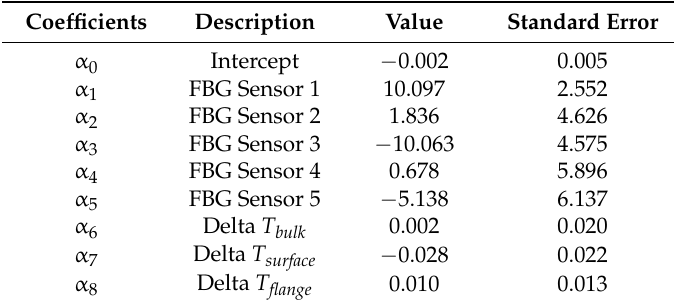
Table 1. Multiple Regression Equation